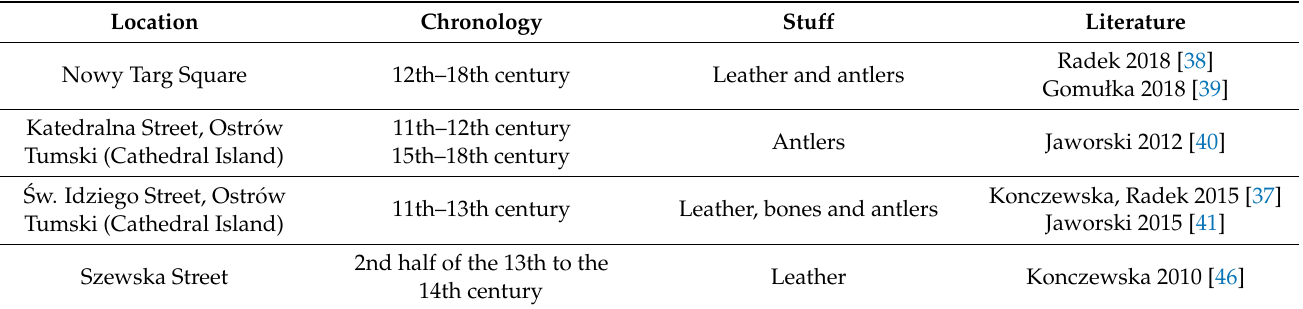
Table 3. Chronology and location of archaeological materials from excavations in